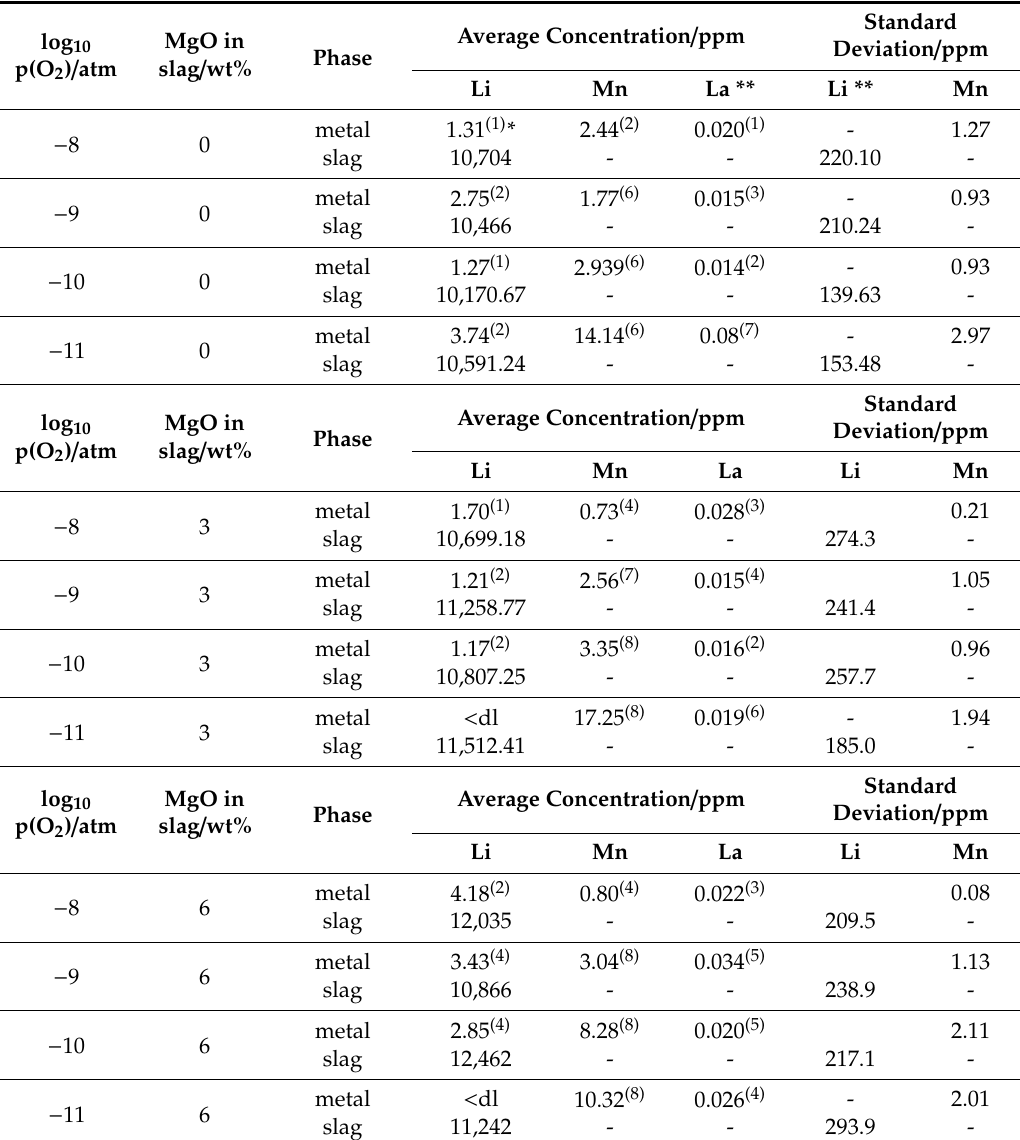
Table A2. Concentration of Li, Mn, and La in metal and slag phases, based on LA-ICP-MS analyses. log